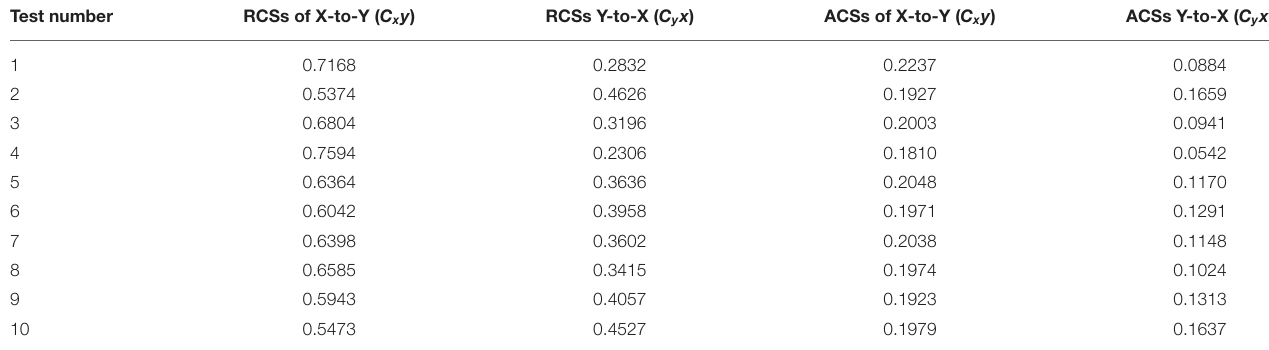
TABLE 7 | Result of robustness and validity